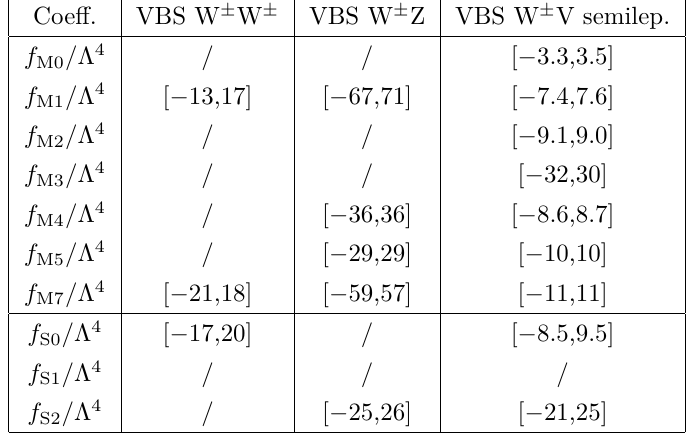
Table 3 . Results for the VBS CMS analyses when applying unitarity constraints. All entries represent 95% CL lower and upper limits in units of TeV − 4 . Bars represent processes for which there is no sensitivity to the corresponding operator, or cases where the theoretical unitarity bound is more stringent than the experimental one for all m cut-off max